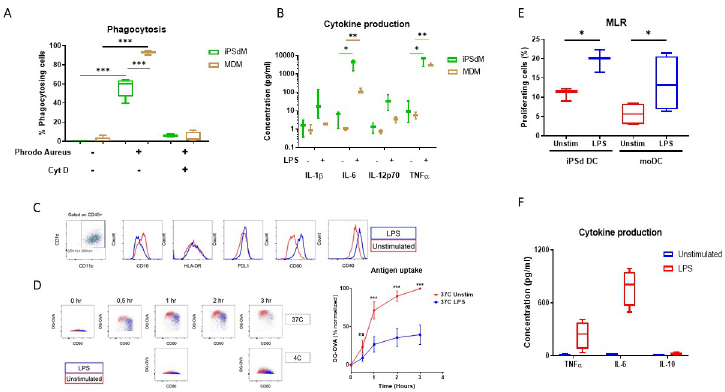
Fig 2. Phenotypic characterization of macrophages and dendritic cells. (A) Phagocytotic capacity measuring S. aureus internalization after 2h and (B) LPS-induced cytokine release both comparing MDM and iPSdM. (C) Gating strategy and surface marker expression and (D) antigen uptake and processing of iPSdDC before and after LPS maturation. (E) Comparison of the antigen presentation capability of both MoDC and iPSdDC measured by T-cell proliferation (Mixed leukocyte reaction; MLR) and (F) cytokine release from iPSdDC before and after LPS activation. � p < 0.05, �� p < 0.01, ��� p <